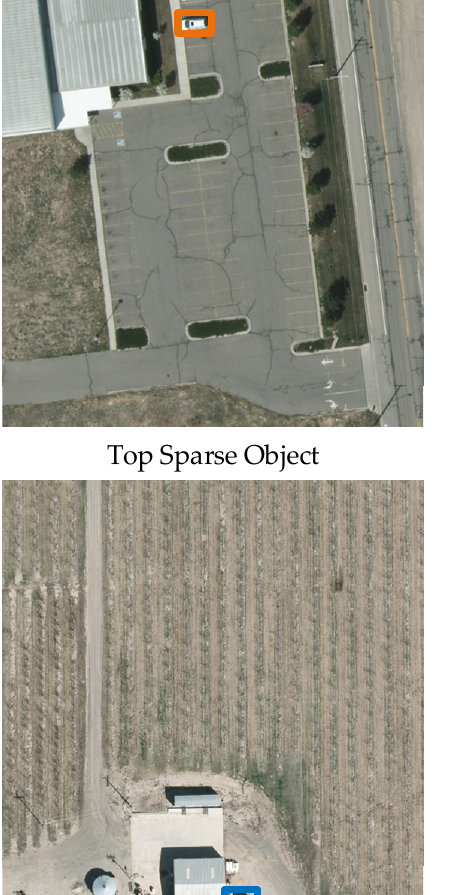
Figure 5. Sparse object dataset leads to unstable training procedure.